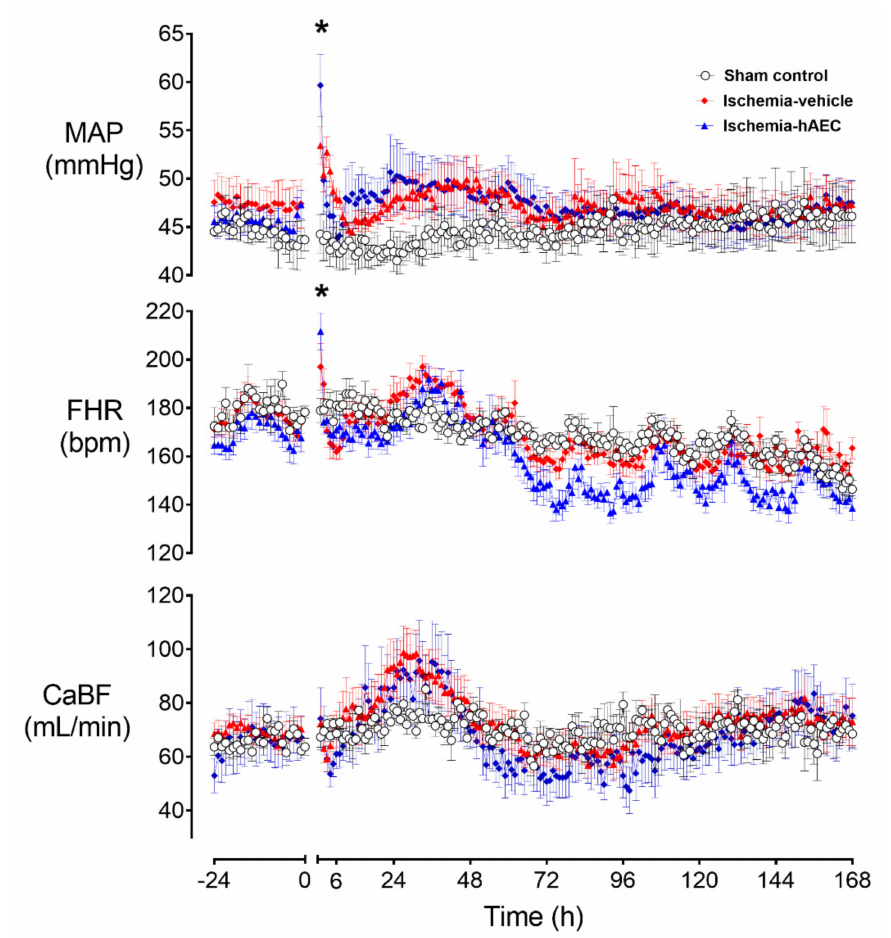
Figure 2. Changes in mean arterial pressure (MAP), fetal heart rate (FHR) and carotid artery blood flow (CaBF) before and after 30 min of global cerebral ischemia in near-term fetal sheep in the sham control (n = 8), ischemia-vehicle (n = 7) and ischemia-hAEC groups (n = 6). Data are 1 h averaged mean ± SEM * p < 0.05 vs. sham